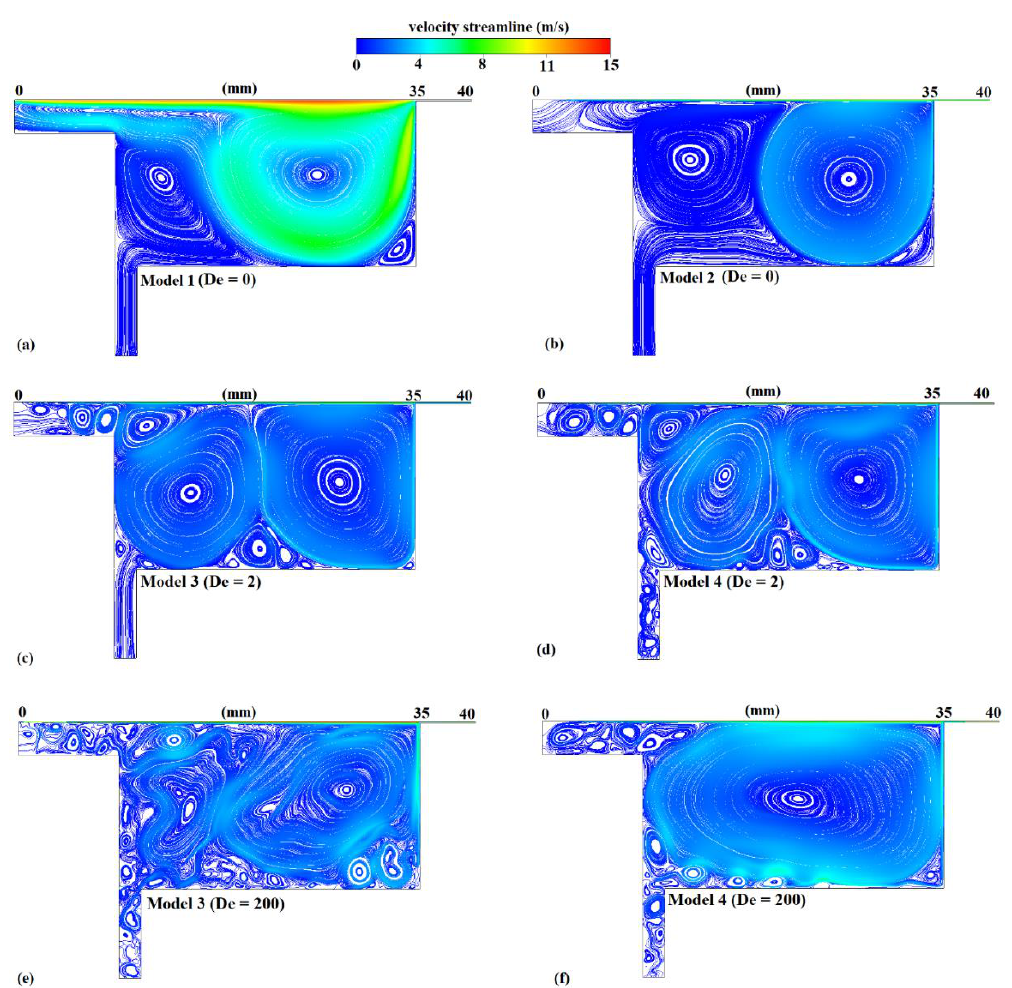
Figure 7. Velocity streamlines for ( a ) model 1, ( b ) model 2, ( c ) model 3 ( De = 2), ( d ) model 4 ( De = 2), ( e ) model 3 ( De = 200), and ( f ) model 4 ( De = 200).